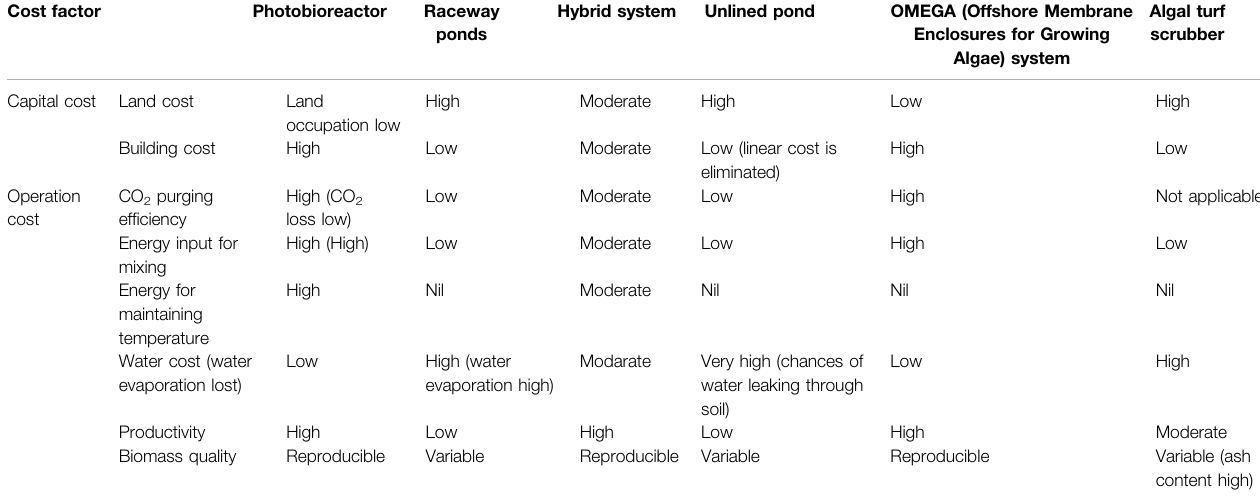
TABLE 1 | Comparison of cost analysis of microalgal cultivation systems.